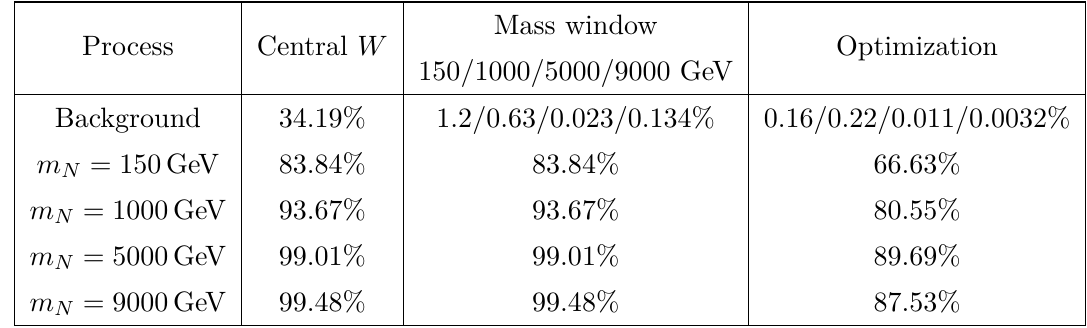
Table 12 . Cutflow table for N e at 10 TeV. All processes after pre-selection are set to